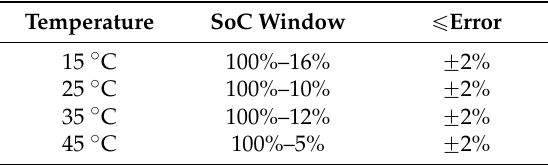
Figure 12. Dynamic behavior of the 1st order Thévenin Model measured and simulated DDP comparison at 25 °C with Coulomb counting and normal characterization. Table 5. Results of the models where the SoC window is less than the proposed error.